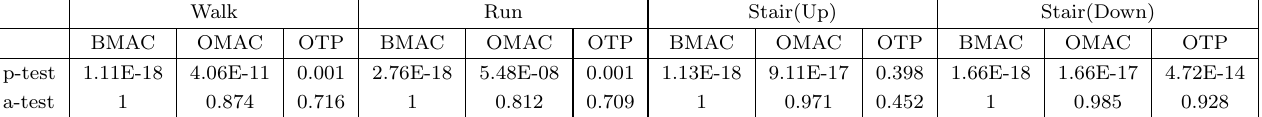
Table 2: Statistically (P-Test) and Scientifically (A-Test) Significant tests on the differences between the transmission protocols using the results collected the hardware experiments